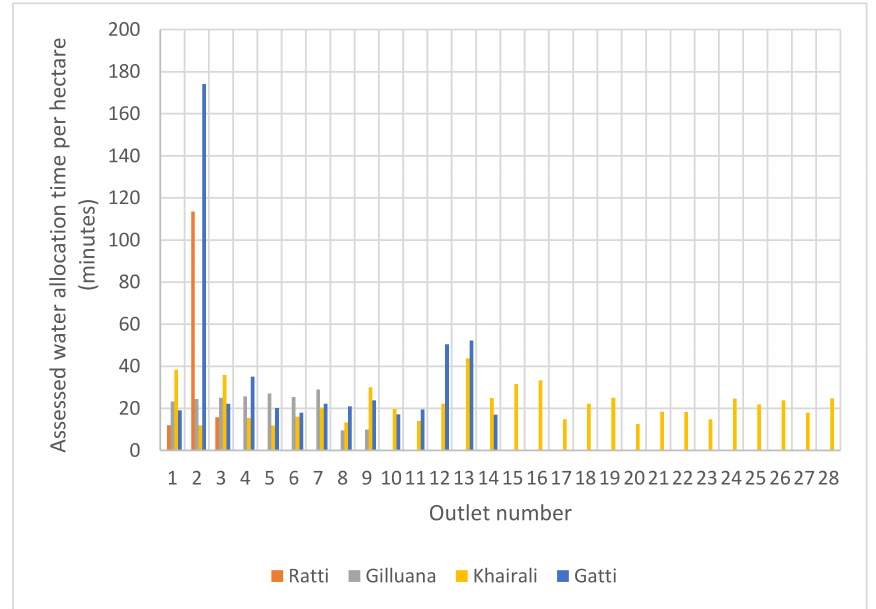
Figure 7. Assessed water allocation time for each outlet in the selected